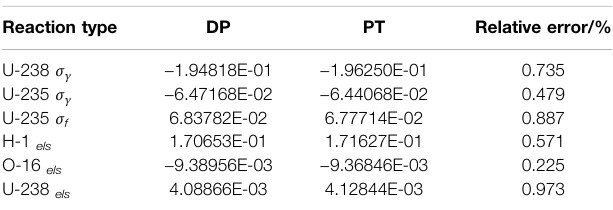
TABLE 2 | Comparison of total sensitivity coef fi cients.